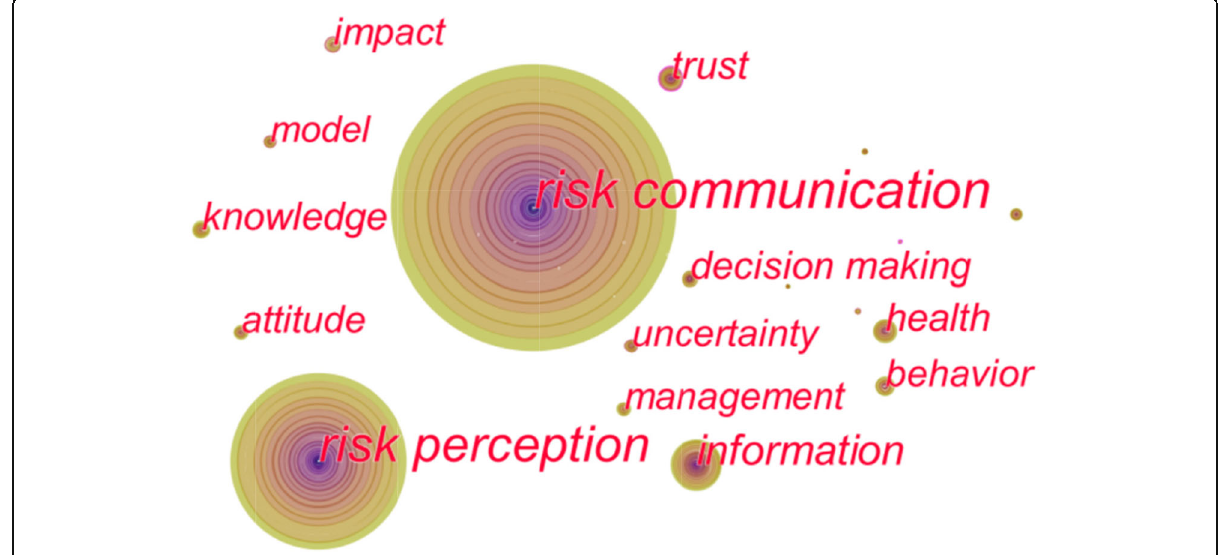
Fig. 4 Keyword co-occurrence network of international